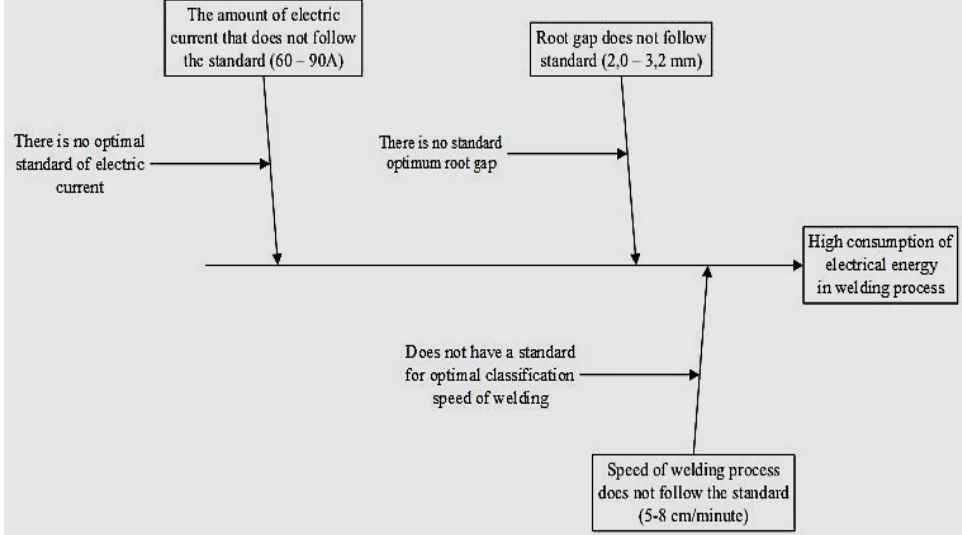
Fig. 3. Fishbone diagram of method factor.